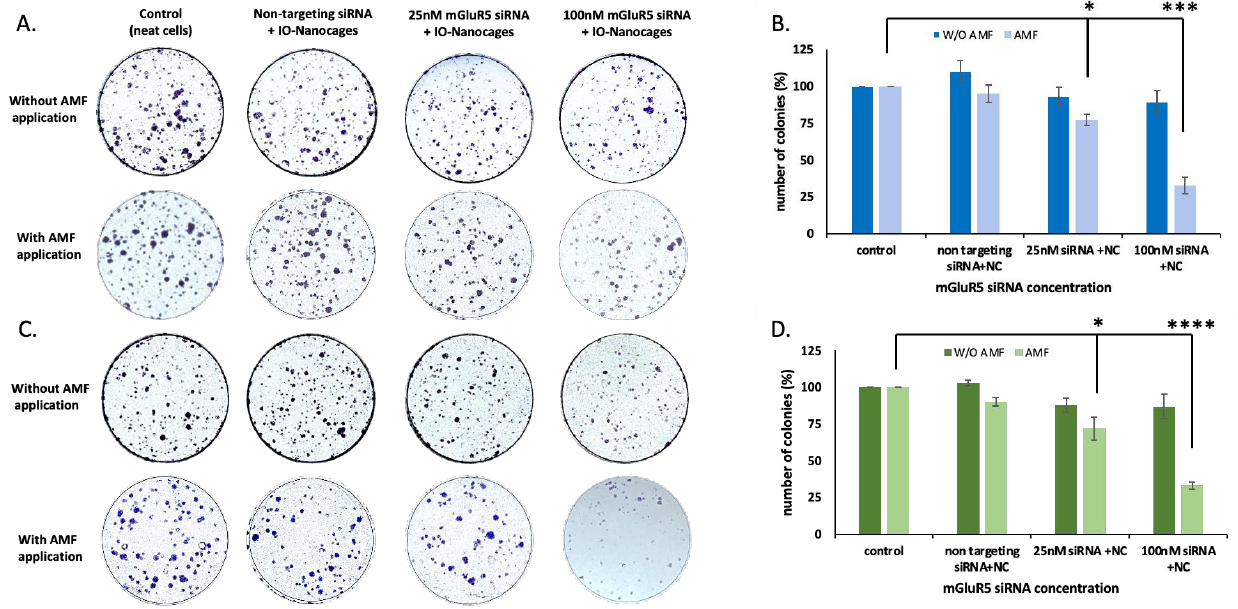
Figure 5. The colony formation of ( A ) LM7 human metastatic osteosarcoma cells and ( C ) OS482 mouse metastatic osteosarcoma cells with and without AMF application (445 kHz) was stained by 0.05% Cresyl violet. The number of colonies were quantified in ( B ) LM7 human metastatic osteosar- coma cells and ( D ) OS482 mouse metastatic osteosarcoma cells. When 100 nM of mGluR5 siRNA was incorporated to IO-nanocages with AMFs, the colony formation was significantly prohibited. * p < 0.05, *** p < 0.001, **** p < 0.0001, N = 3.